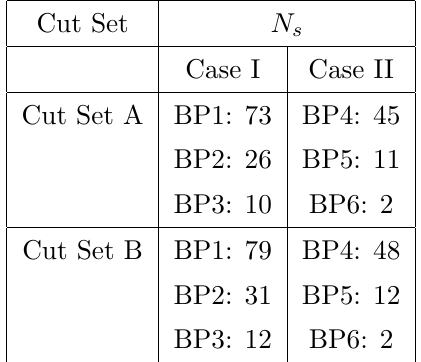
Table 4 . Number of signal events, surviving all the cuts, at an integrated luminosity of 3000 fb (cid:0) 1 for Case I ( m signature.